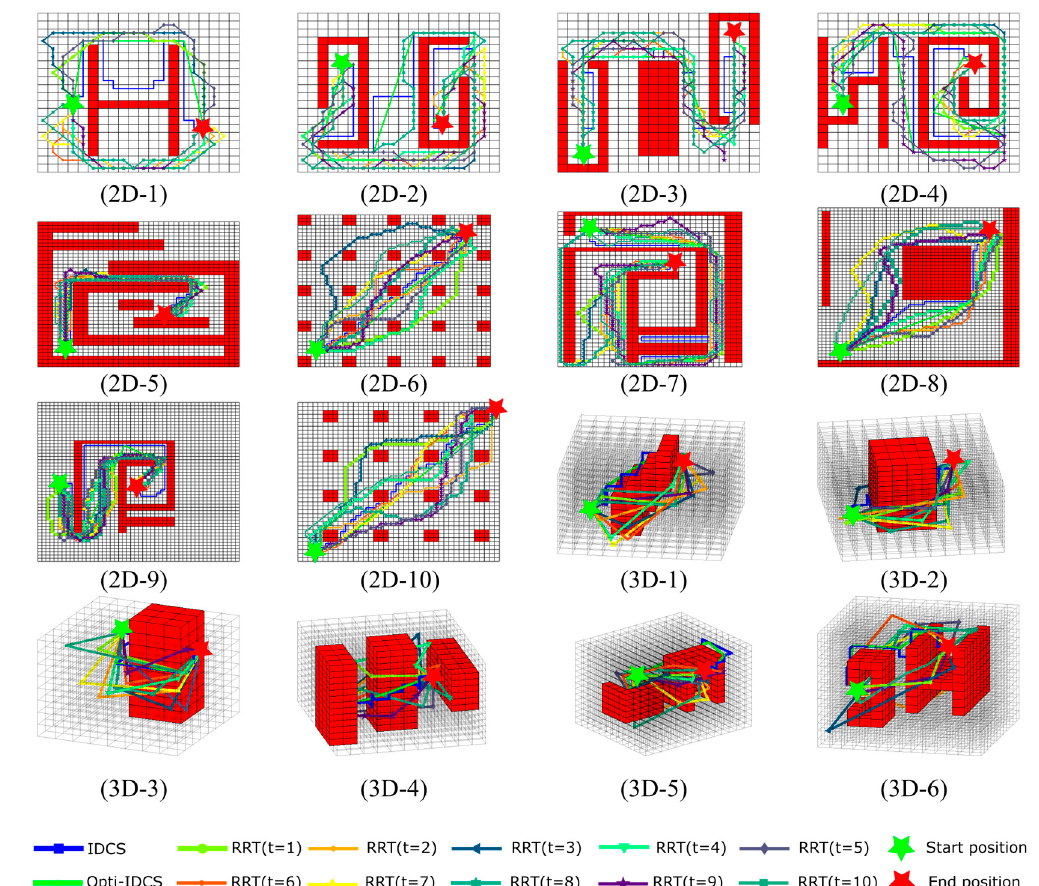
Figure 13. The planned path for various maps. The results generated by the IDCS and Opti-IDCS methods keep the same for each experiment; the path generated by the RRT method is different for each